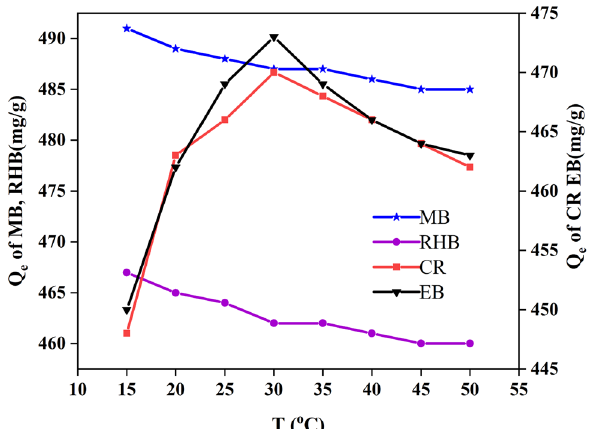
Fig. 6 The influence of temperature value on the Q and EB adsorbed by PAA/PAM/[DMAEMA]MA hydrogel